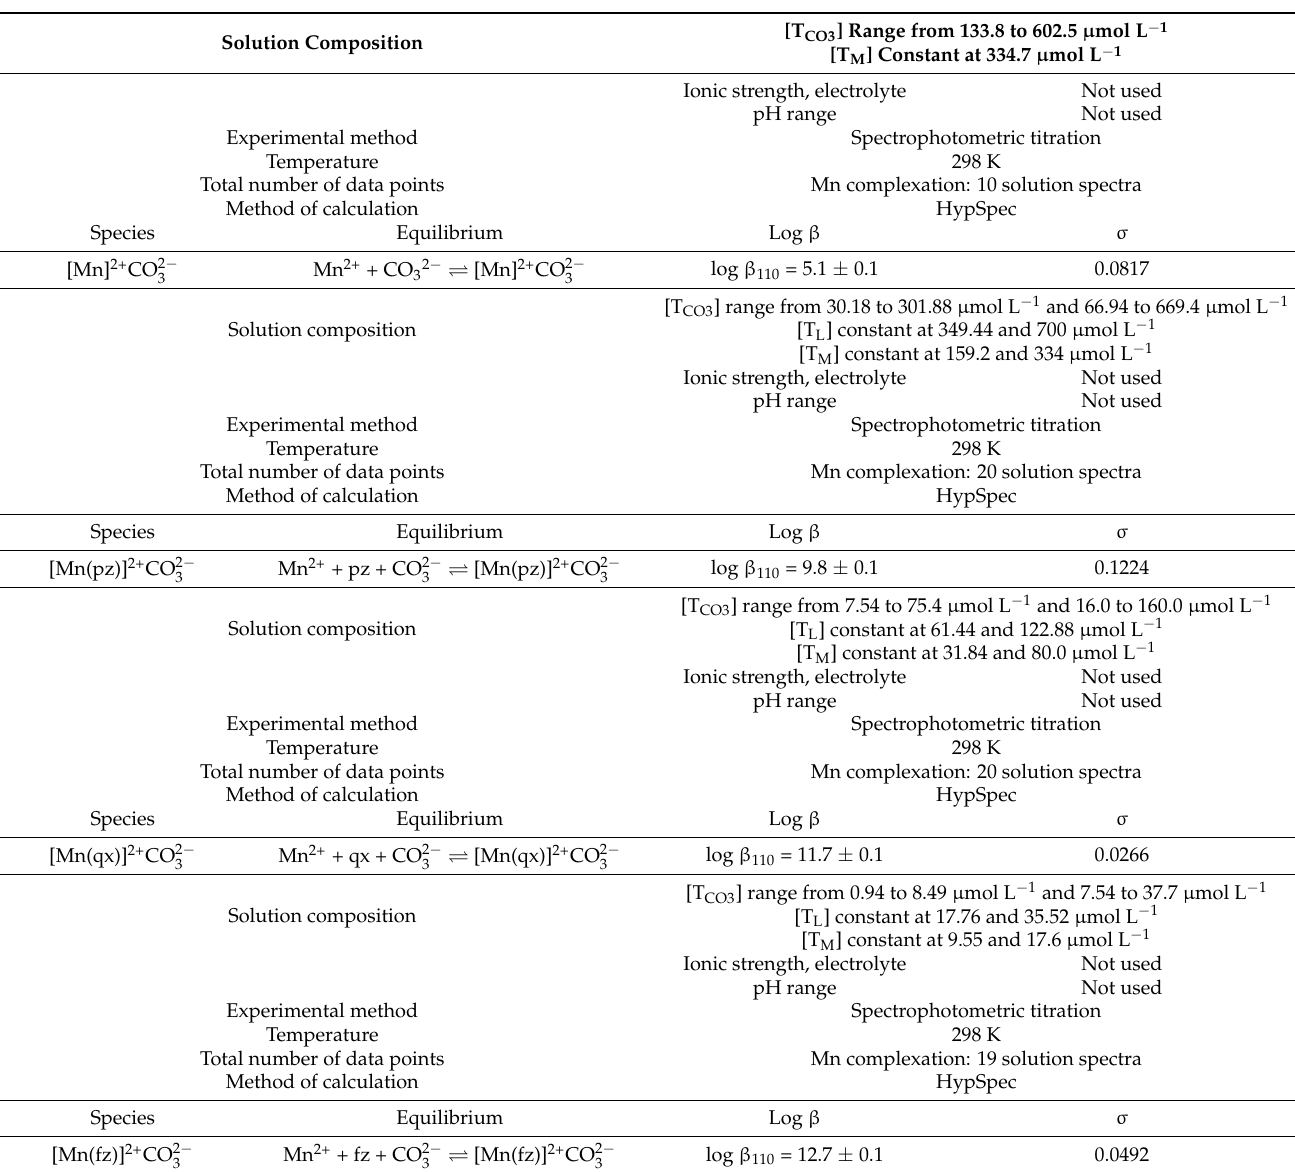
Table 2. Summary of experimental parameters for the systems Mn(II)–carbonate and Mn(II)–ligand– carbonate, where the ligand is pyrazine (pz), quinoxaline (qx) or phenazine (fz), in methanol. Solution